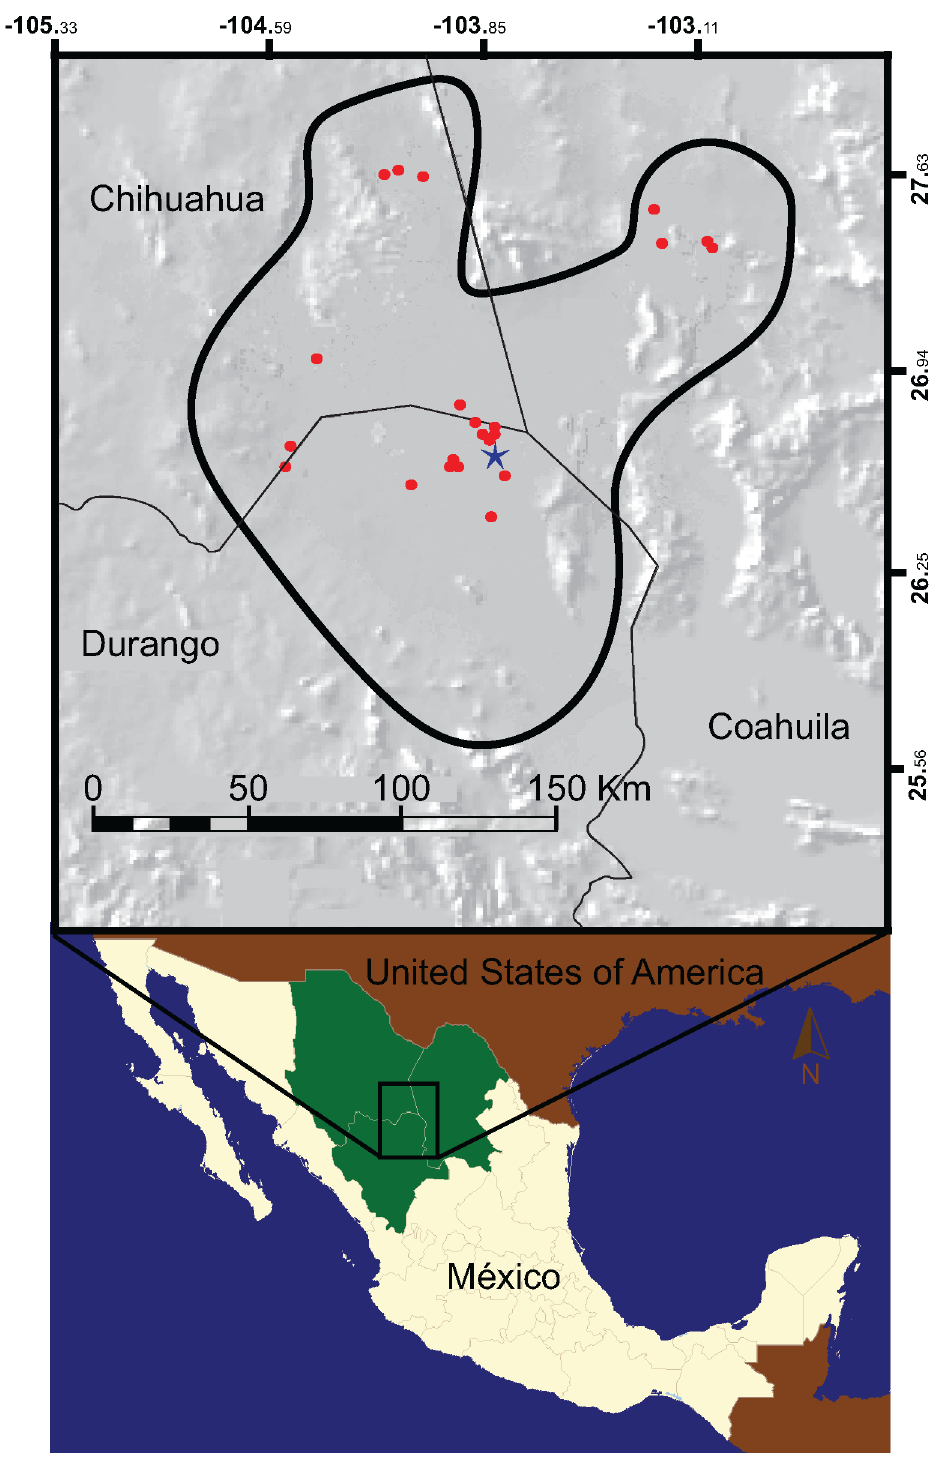
Fig 1. Geographic distribution of Gopherus flavomarginatus . The thick black line delineates the polygon of the Mapimí Biosphere Reserve, whereas the state borders are mark by the thin black lines. Red dots pinpoint the sites where the abundance data for the Bolson tortoises was recorded. The star indicates the location of the Mapimí field station.